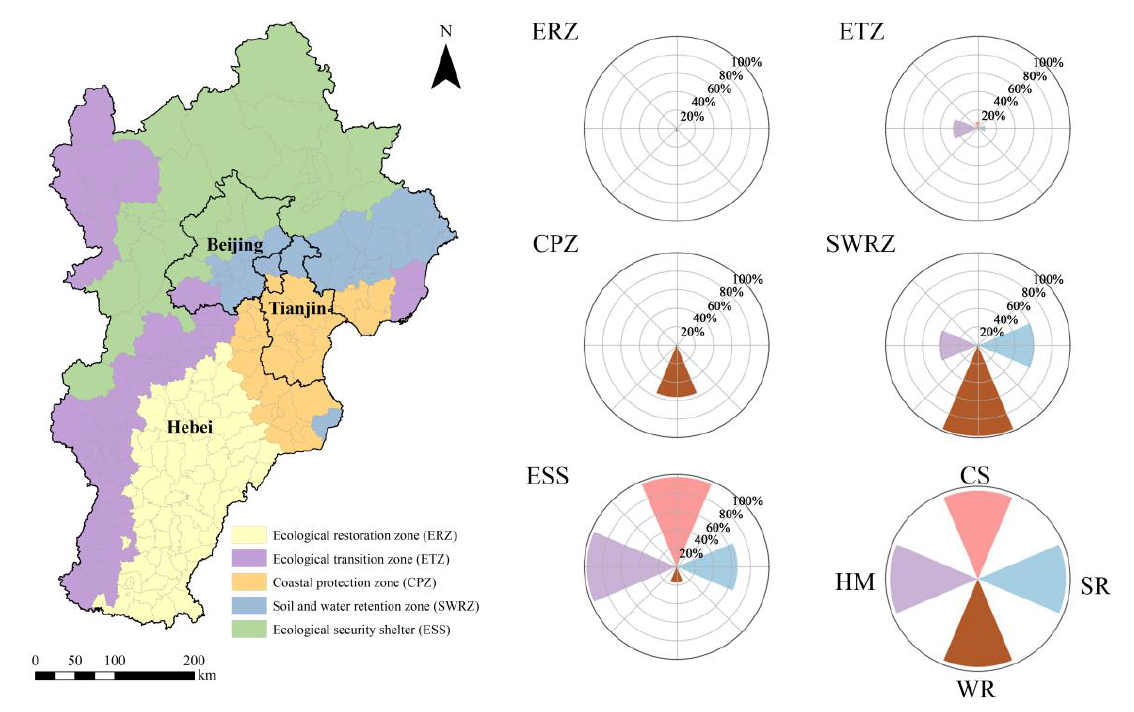
Figure 5. Spatial pattern of ecological zones of the BTH region and the proportion of hot spots and sub-hot spots of ecosystem services in each zone.